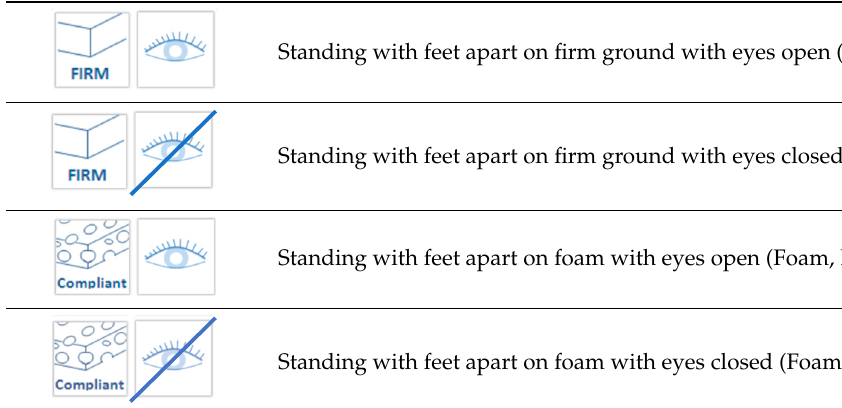
Table 3. The mCTSIB standing exercises. Three 30-second repetitions of each exercise were per- formed with a single IMU placed on the participants’ lower backs.